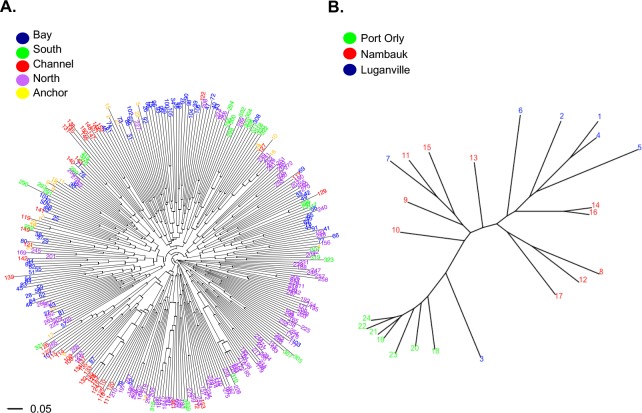
Phylogenetic analysis of Plasmodium vivax isolates of the Southwest Pacific.For the lower transmission regions of (A) Ngella and (B) Vanuatu, relatedness amongst haplotypes was defined by calculating the pairwise distance and visualized by drawing unrooted phylogenetic trees using the APE package in R software. Colours indicate the geographic origin of each sample as indicated in the key.